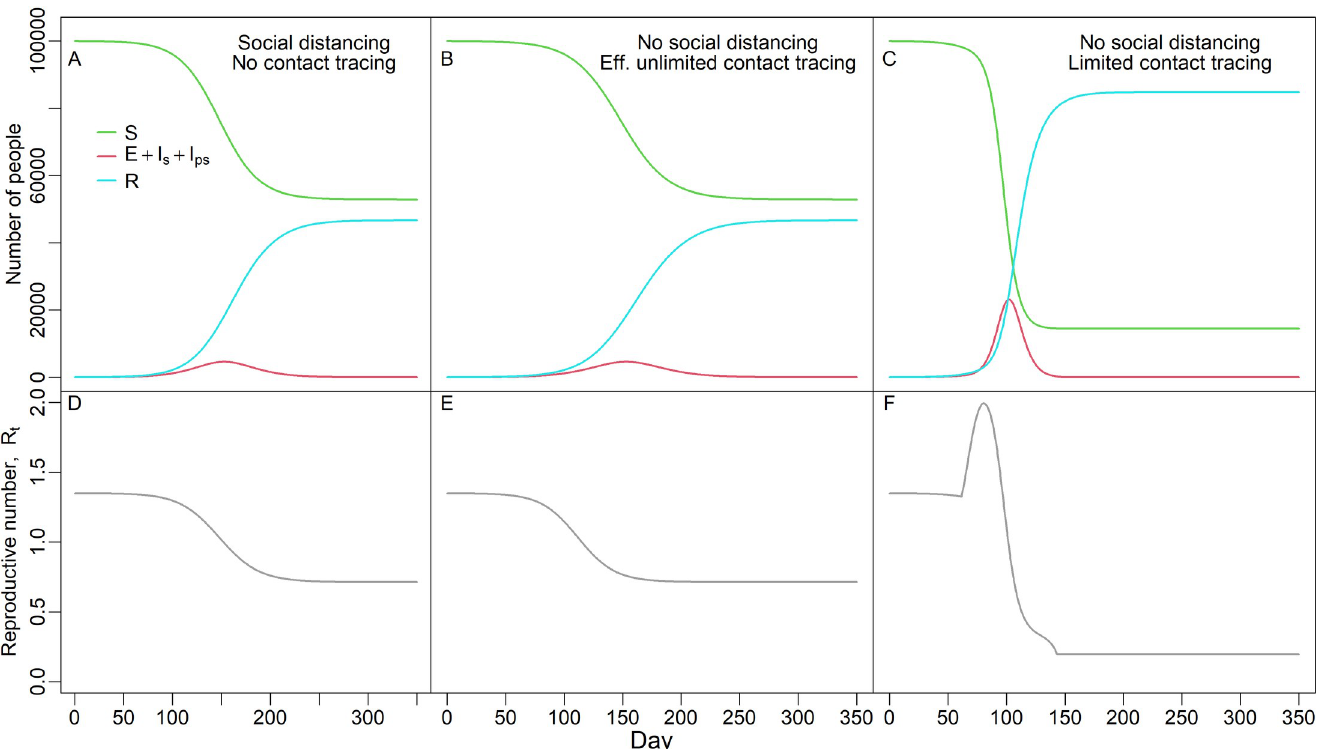
Fig 3. Reduced contact tracing efficiency with increasing cases leads to accelerating epidemics. Top panels (A, B, C) show the number of susceptible, infected (latent, pre-symptomatic and symptomatic combined), and recovered individuals. Bottom panels (D, E, F) show the reproductive number, R t , over time. Left most panels (A, D) show dynamics with no contact tracing but social distancing ( κ = 0.58) set to give same initial R 0 (1.35) as with contact tracing. Middle panels (B, E) show dynamics with effectively unlimited contact tracing (1500 contact tracers making 12 calls/day; 10 contacts per case) but no social distancing ( κ = 1), with an identical value of R 0 as in panels A, D. Right panels (C, F) show dynamics with the same parameter values as (B, E) except with limited contact tracing (15 contact tracers). R 0 is the same value as in panels D and E (R 0 = 1.35), but R t increases as cases increase and contact tracing becomes inefficient, which overwhelms the decrease in the fraction of the population that is susceptible. In all panels, the delay from symptom onset to receiving test results, 1/ τ Is , is 5d. All populations start with 100,000 individuals. Note the identical epidemic sizes (final fraction susceptible 0.53) for panels A (social distancing) and B (effectively unlimited contact tracing), but much larger epidemic size for limited contact tracing in panel C (final fraction susceptible